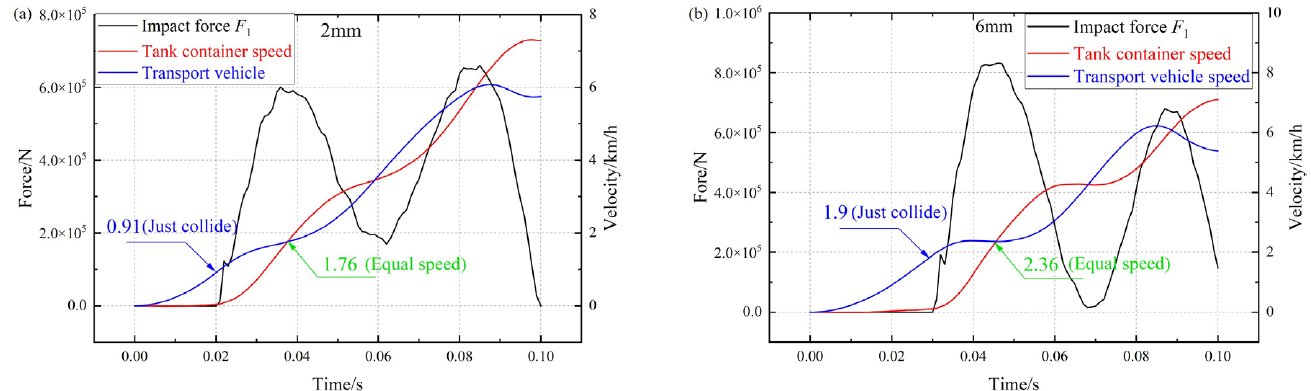
Figure 16. Relationship between the F 1 and the velocity of the transport vehicle and tank container ( a ) at 2 mm initial clearance; ( b ) at 6 mm initial clearance.